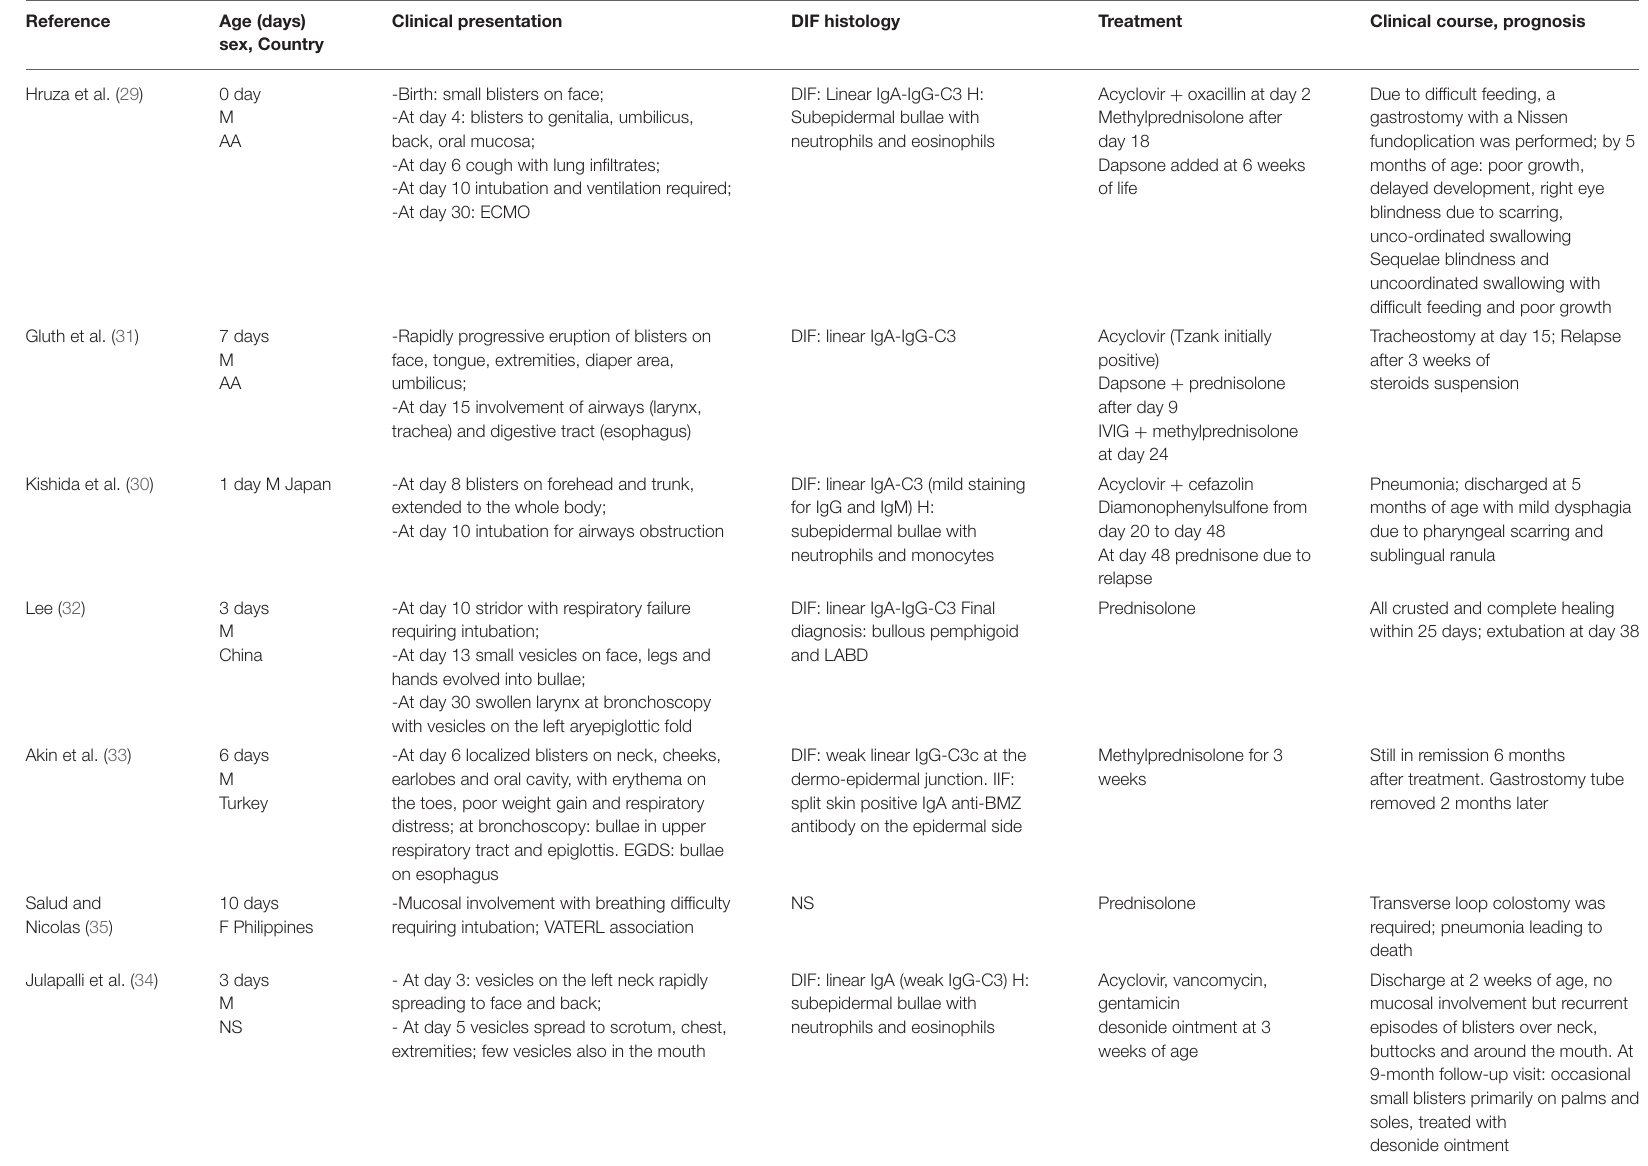
TABLE 3 | Neonatal cases of